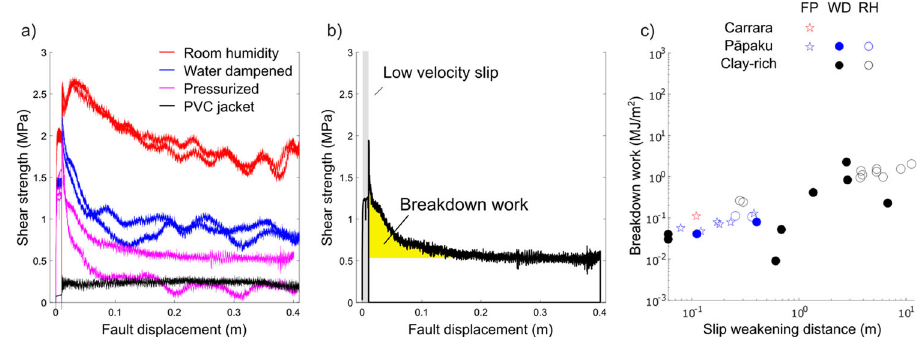
Fig. 4 Shear strength and breakdown work W b of the P ā paku thrust materials. a The fault core materials of the P ā paku thrust under fl uid-pressurised conditions (magenta lines) have the lowest residual stress and smallest slip weakening distance compared to those deformed under room humidity (red lines) or water-dampened (blue lines) conditions. The strength of the PVC jacket is presented for reference (black line). b Breakdown work W b (yellow shaded area) or energy dissipated to achieve the minimum shear strength during seismic slip controls earthquake rupture propagation: smaller W b , increasing ease of rupture propagation. c Breakdown work W b versus slip weakening distance D w for P ā paku thrust materials and Carrara marble gouge with respect to a collection of W b in clay-rich gouges at seismic slip rates (45 – 55 wt% phyllosilicates content 35 ). Data points are grouped by both lithology and experimental conditions, which are reported as fl uid pressurised (FP), water dampened (WD), and room humidity (RH). Our experimental results yield breakdown work comparable with the one measured under similar materials and deformation